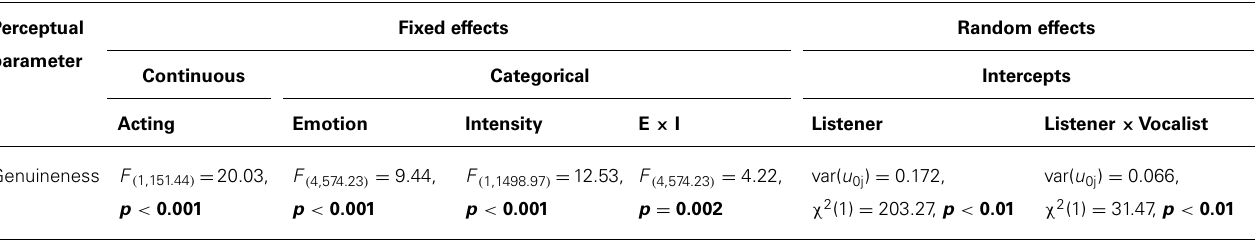
Table 2 | Summary of results from the linear mixed model in Experiment 2 comparing listeners’ ratings of emotional genuineness with vocalist training background of the